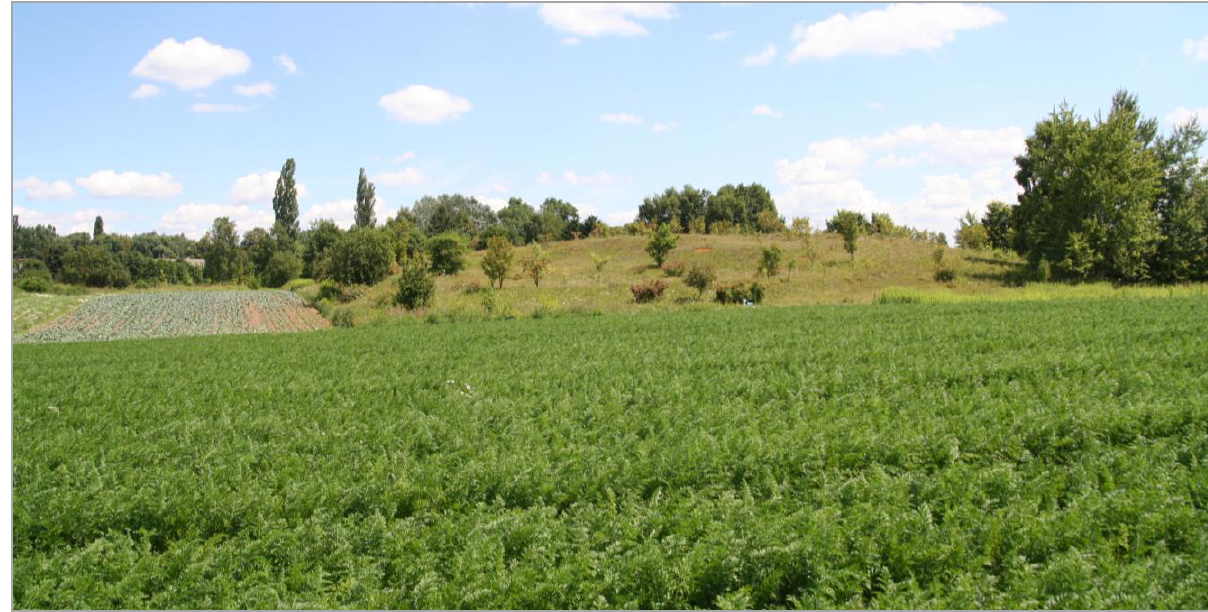
Fig. 3. The "Dołki" washery spoil heap in the Brzeziny Śląskie n. Piekary surrounded by its agricultural landscape ( A. Rostański )